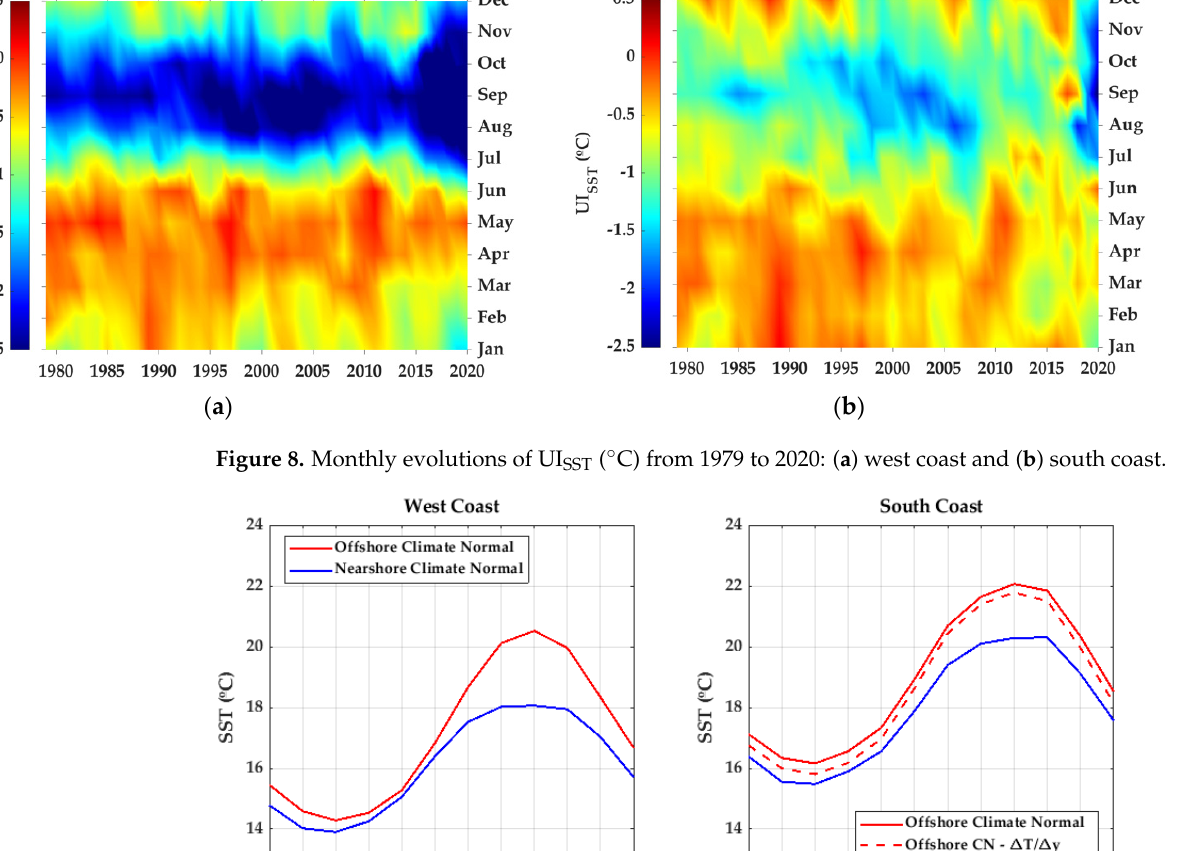
Figure 8. Monthly evolutions of UI SST (°C) from 1979 to 2020: ( a ) west coast and ( b ) south coast.